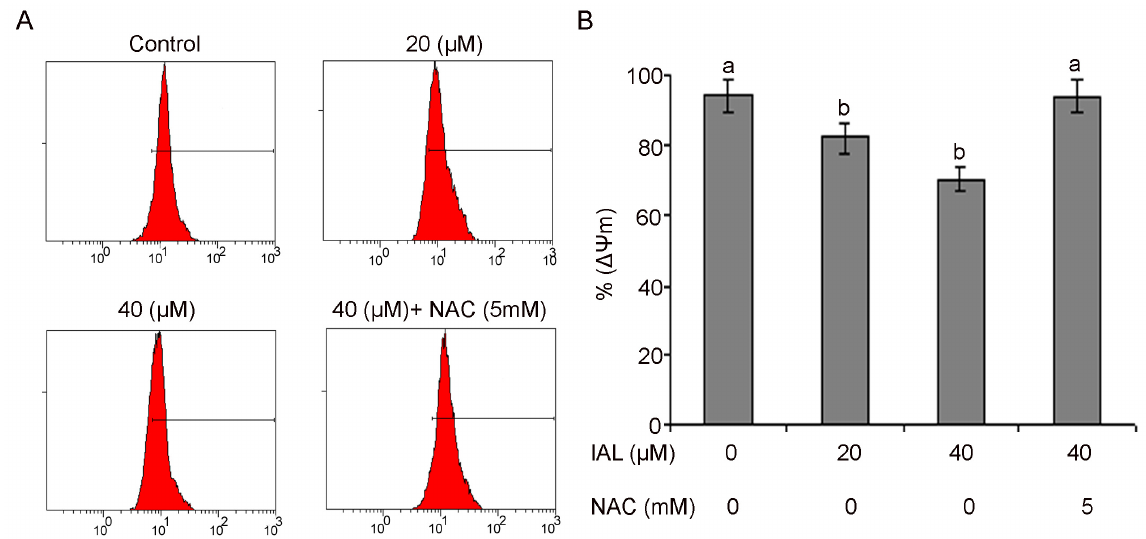
Figure 7. The effects of isoalantolactone on mitochondrial transmembrane potential of PC3 cells were determined by flow cytometry. ( A ) The values indicate the percentages of rhodamine 123 fluorescence in the PC3 cells treated without and with 20 and 40 µM of isoalantolactone (IAL) for 24 h in the presence or absence of NAC. ( B ) Data are expressed as Mean ± SD (n = 3). Columns not sharing the same superscript letter differ significantly ( p < 0.05).